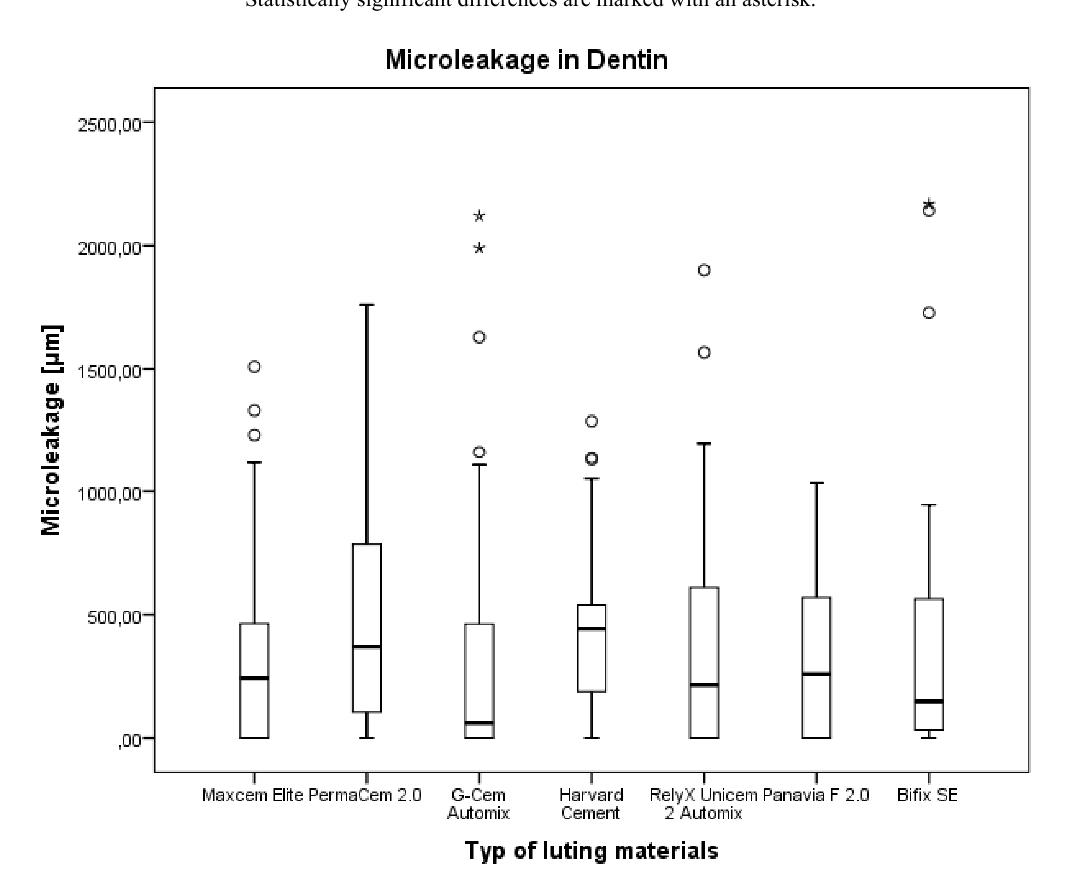
Figure 5. Comparison of the microleakage in dentin for the luting materials. Description of boxplot see Figure